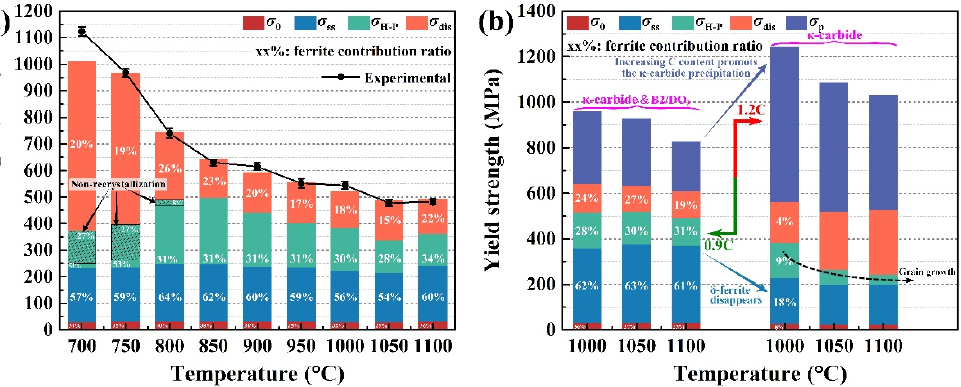
Figure 3. The calculated yield strength values for assessing the strengthening mechanisms of the ( a ) Fe-11Mn-7Al-0.6C steel and ( b ) Fe-11Mn-10Al-0.9/1.2C steels under various annealing tempera- tures [46]. (Reprinted with permission from [46]. Copyright 2022 Elsevier).